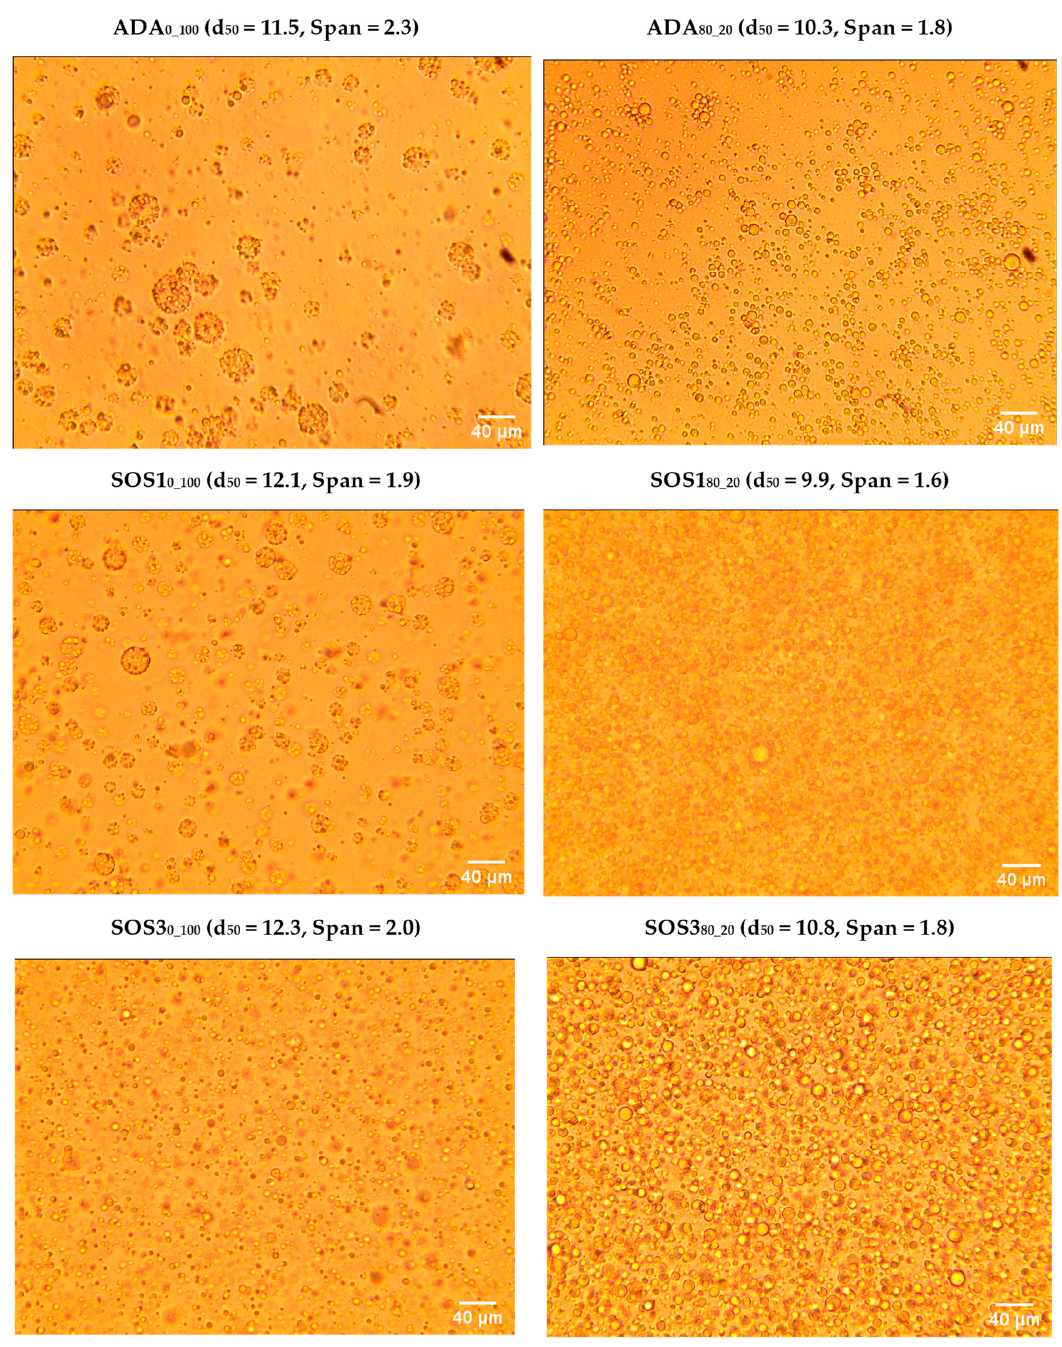
Figure 4. Optical microscopy images with a scale bar of feed emulsions of the three starch grades ADA, SOS1, and SOS3 stabilized with polysaccharides only (ADA 0_100 , SOS1 0_100 , SOS3 0_100 ) or polymer/polysaccharides 80/20 (ADA 80_20 , SOS1 80_20 , SOS3 80_20 ).